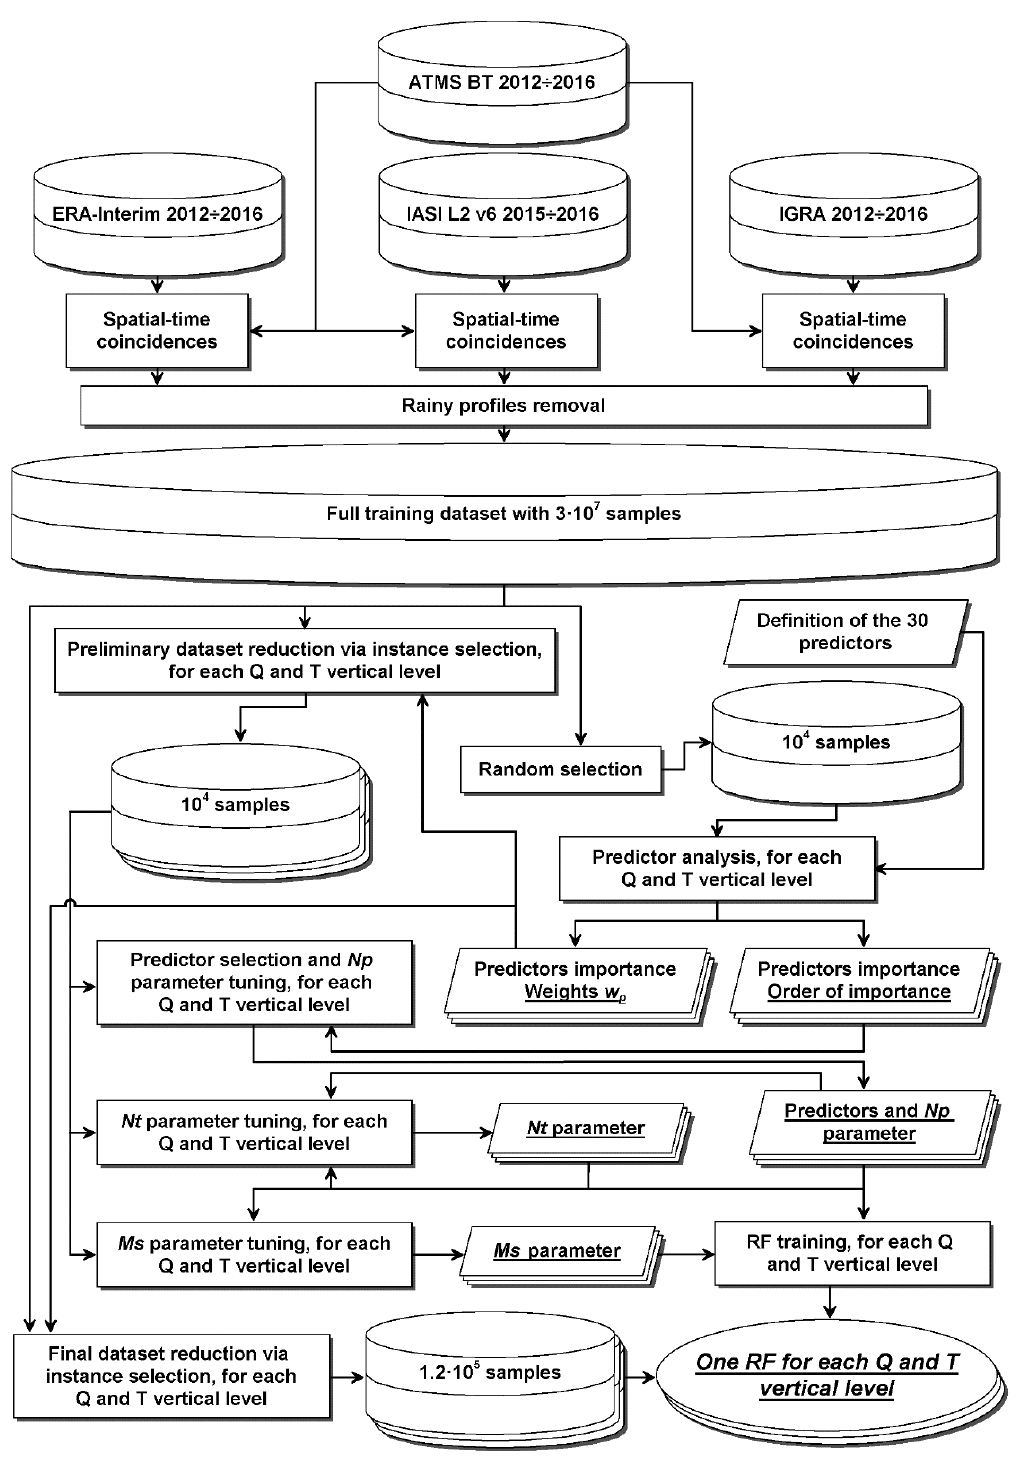
Figure 2. Flowchart of the action performed to develop the algorithm detailed in Section 3. Q: Water vapor mixing ratio, T: Temperature, RF: random forest, Nt : number of trees in the forest, Np : number of randomly selected predictors, Ms : minimum size of the terminal node.